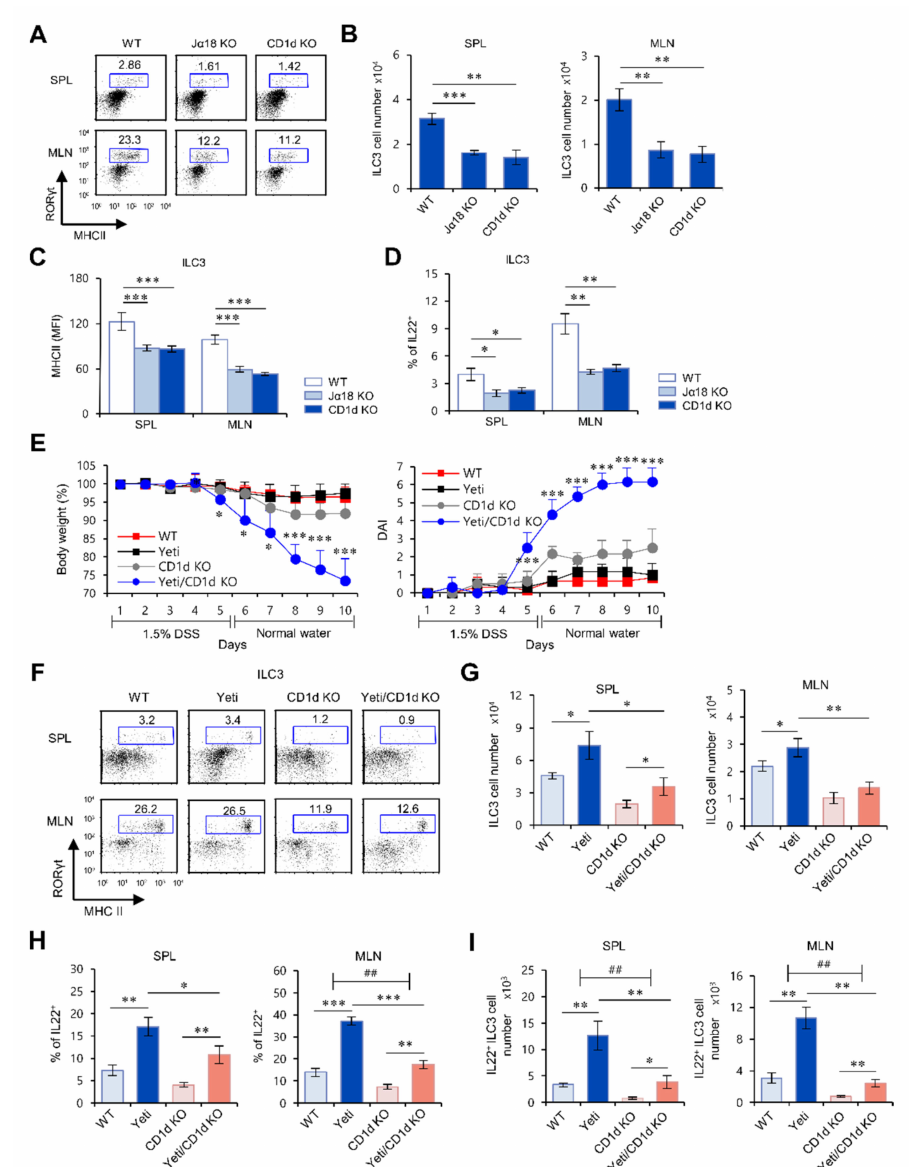
Figure 2. The frequency and function of ILC3s in the MLN of Yeti mice are dependent on CD1d- dependent iNKT cells. ( A – D ) The spleen and MLN were prepared from WT, J α 18 KO, and CD1d KO mice at six weeks of age. ( A , B ) The absolute numbers of ILC3s (ROR γ t + MHC II + Lin − ) in the spleen and MLN from these mice were assessed by flow cytometry. Representative data ( A ) and their summary ( B ) are shown. ( C ) MHC II expression by splenic and MLN ILC3s (ROR γ t + Lin − ) from these mice was determined by flow cytometry. ( D ) IL22 production by splenic and MLN ILC3s (MHC II + ROR γ t + Lin − ) from these mice was analyzed by flow cytometry. ( E – I ) Daily body weight changes and DAI scores of WT, Yeti, CD1d KO, and Yeti/CD1d KO mice were evaluated after 1.5% DSS treatment. ( F , G ) The absolute numbers of ILC3s (MHC II + ROR γ t + Lin − ) in the spleen and MLN from these mice were assessed by flow cytometry ten days after DSS treatment. ( F ) Representative FACS plots and ( G ) summary. ( H ) IL22 production by splenic and MLN ILC3s (MHC II + ROR γ t + Lin − ) from these mice was determined by flow cytometry on day 10. ( I ) The number of IL22-producing ILC3s among these cells was assessed by flow cytometry on day 10. The mean values ± SD ( n = 5; per group in the experiment; Student’s t -test; * p < 0.05, ** p < 0.01, *** p < 0.001) are shown. Two-way ANOVA (Yeti × iNKT) showed an interaction between these two factors ( ## p < 0.01). One representative experiment of two experiments is